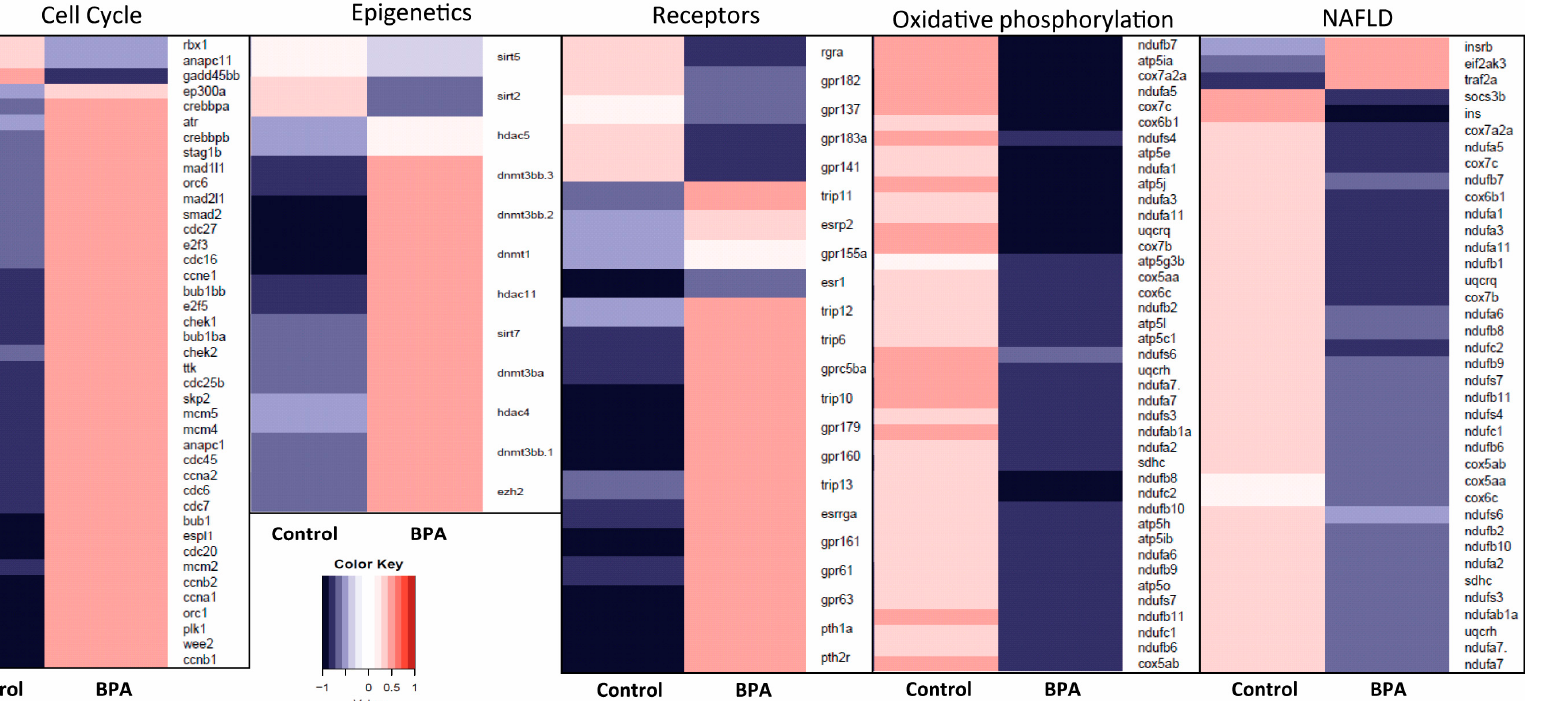
Figure 8. Heatmaps of gene expression changes between BPA exposed and control liver for selected modules of interest. Red and blue boxes indicate relative over ‐ and under ‐ expression with respect to a mean level between the two groups. Only significant DE genes have been included (q ≤ 0.1). In the BPA ‐ exposed liver, many transcripts related to Epigenetics and Cell cycle pathways were upregulated compared to control. Many transcripts belonging to the Non ‐ alcoholic fatty liver disease (NAFLD) and Oxidative phosphorylation modules were downregulated in BPA ‐ exposed zebrafish.